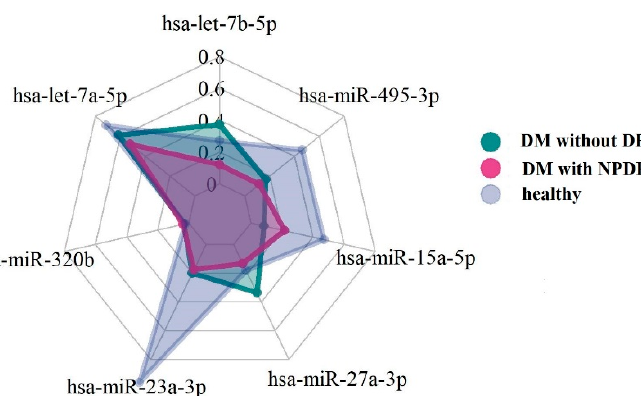
Figure 2. Radar plot for median values of miRNAs.